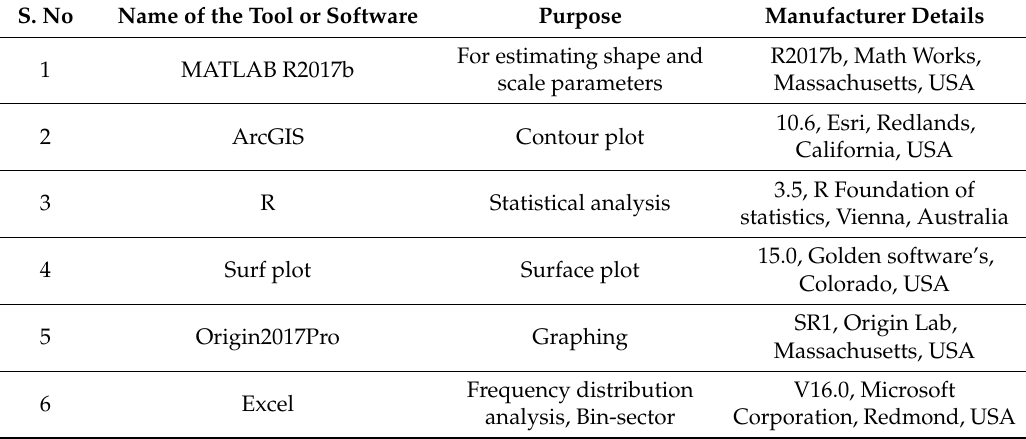
Table A1. Various tools and software’s used for